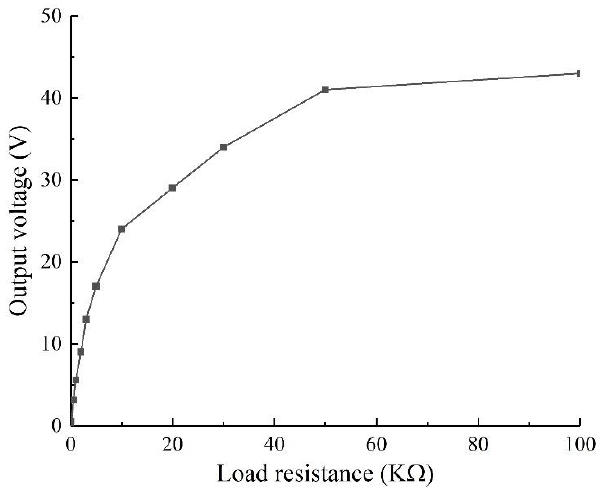
Figure 4. Correlation analysis of resistance under different loads.